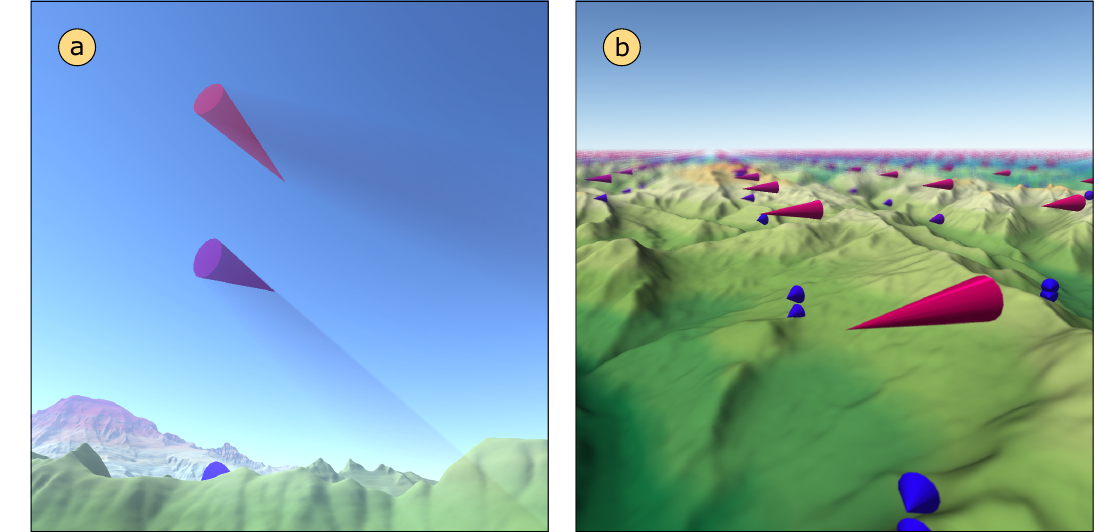
Figure 9. Enhancing the perception of the spatial distribution of objects within terrain. The images show wind glyphs that encode wind direction (arrow head) and strength using length and a continuous color scale, ranging from blue (light wind) to red (high wind). ( a ) shows the application of volumetric light. In this case, the shadowing effect is stressed for illustrative purpose. In ( b ), depth of field is applied to improve depth